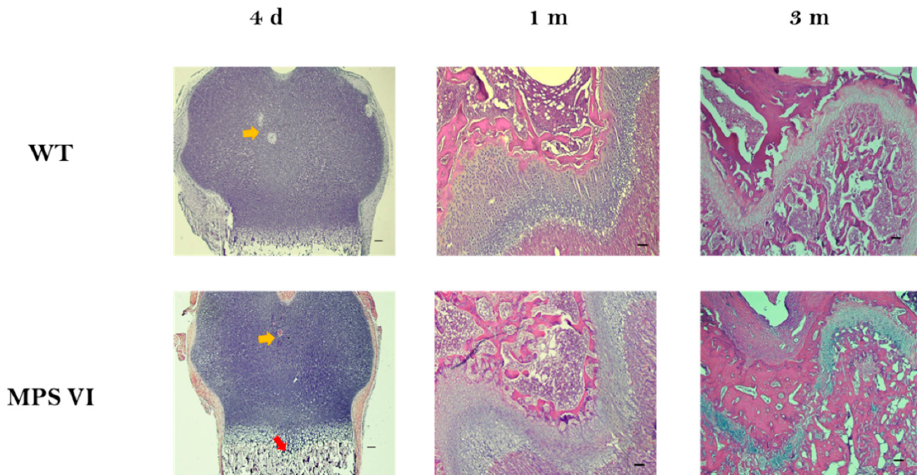
Figure 7. Histological characteristics of growth plates from WT and MPS VI rats. Histological sections stained with hematoxylin and eosin. Images are at 10× magnification. Scale bars correspond to 100 µm. Yellow arrow shows initial regions of ossification in the center of the epiphyses. The red arrow shows changes in the ossification front. Representative samples ( n = 3 per group).